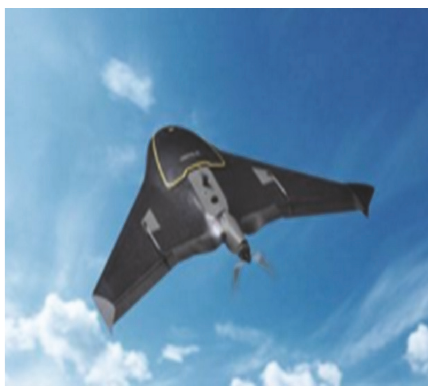
Figure 11: UAV and its antenna